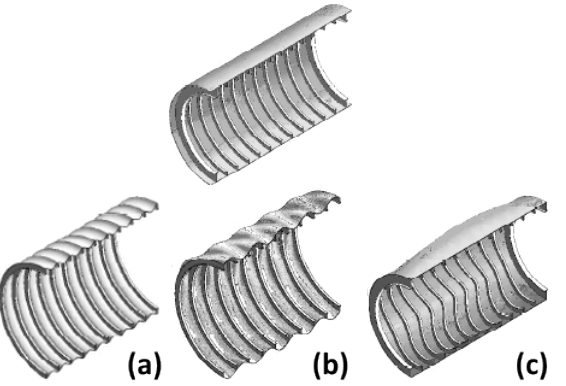
Figure 1. Cylindrical structure with non-deformed internal rings (on top), subjected to yielding ( a ), local instability ( b ), and general instability ( c